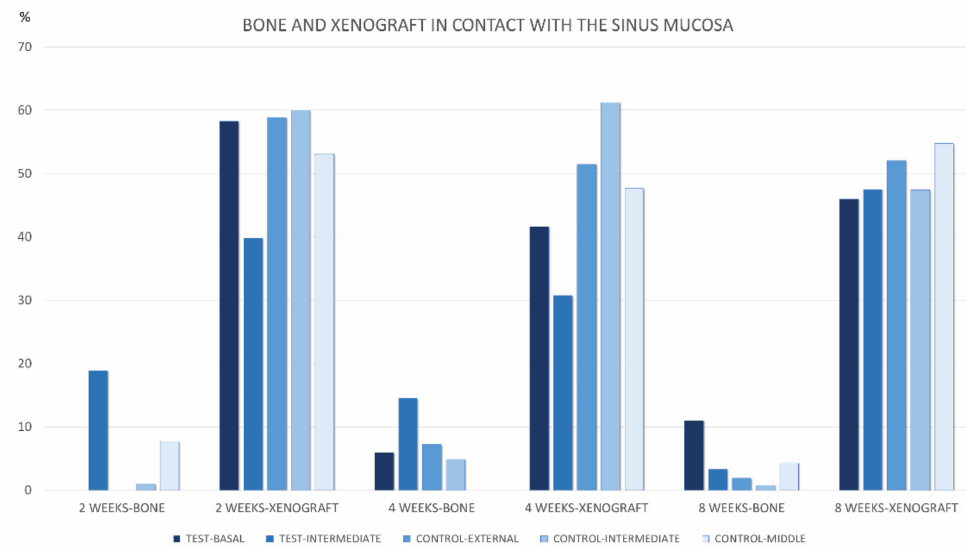
Figure 6. Graph representing the percentage of new bone and xenograft in contact with the sinus mucosa in the various regions evaluated after 2, 4, and 8 weeks of healing.